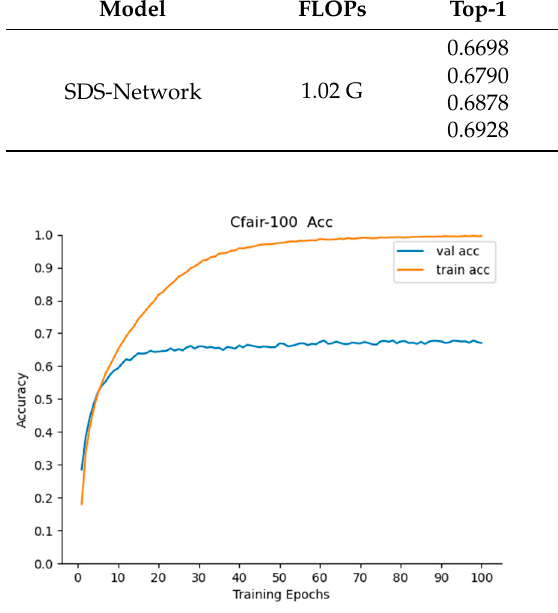
Figure 12. Acc change curve of 100 iterations of SDS-Network algorithm.